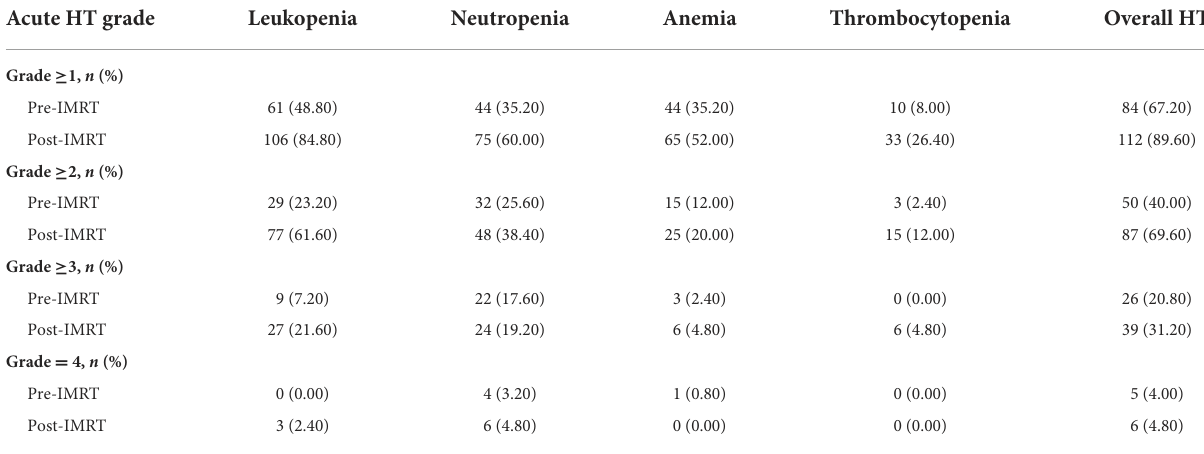
TABLE 2 Acute hematological toxicity before and during radiotherapy in patients with cervical cancer.